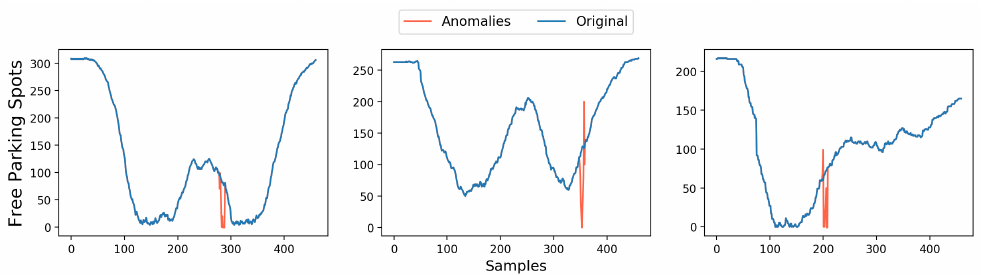
Figure 5. Data with injected anomalies at different instances.